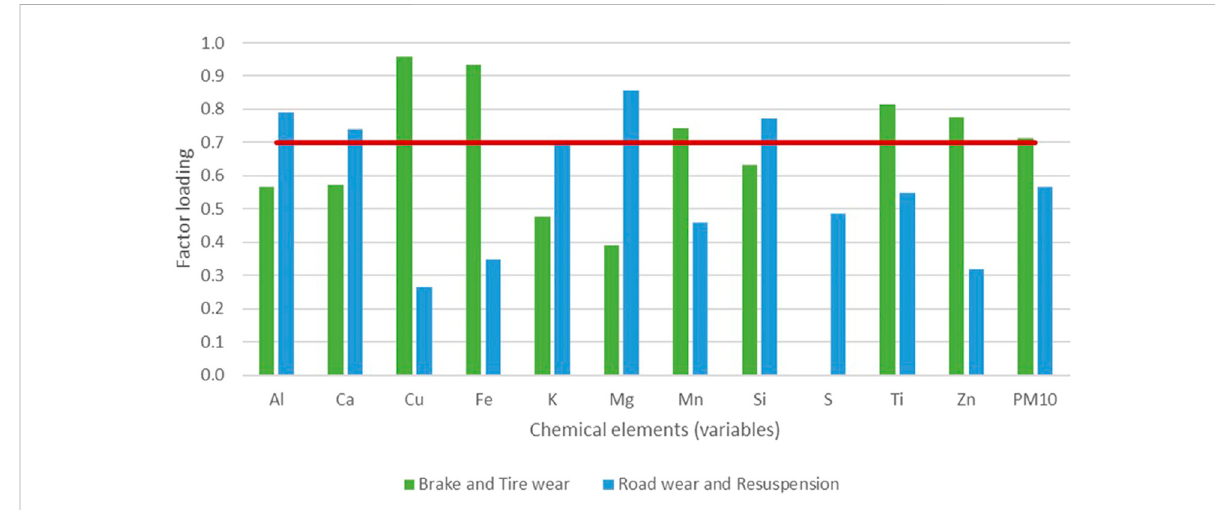
FIGURE 11 Factor loadings of variables (chemical elements and PM) to factors (PM sources) for data matrix PM 10 obtained by FA.